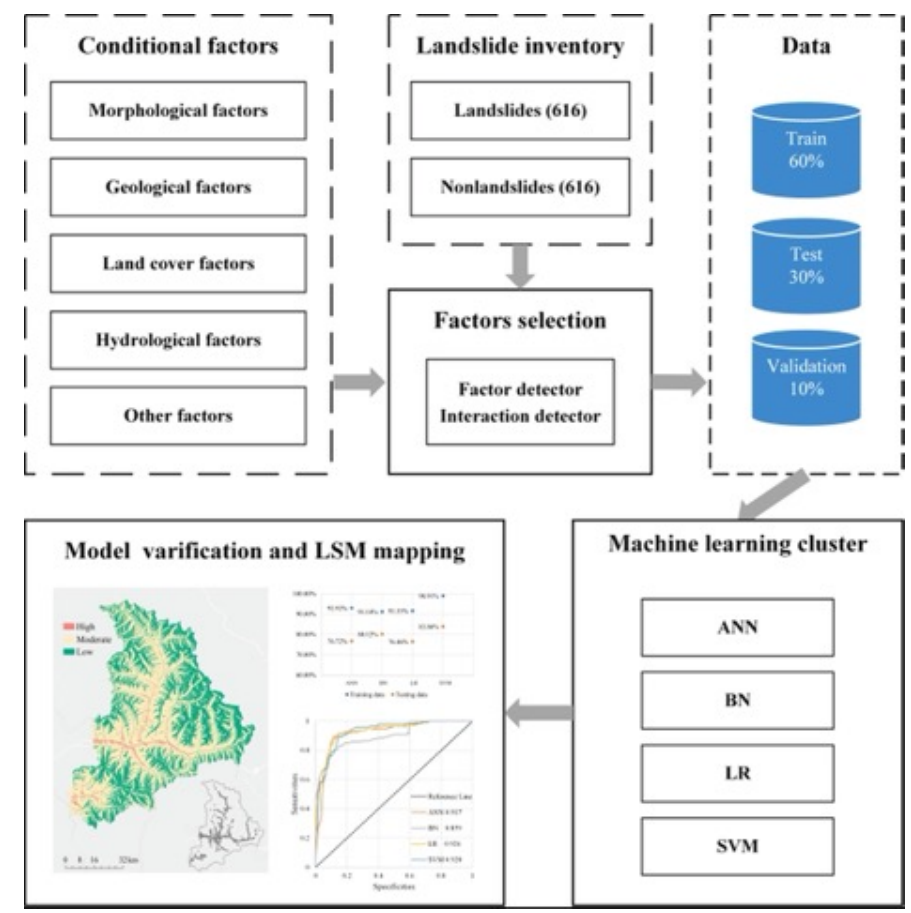
Figure 3. Method